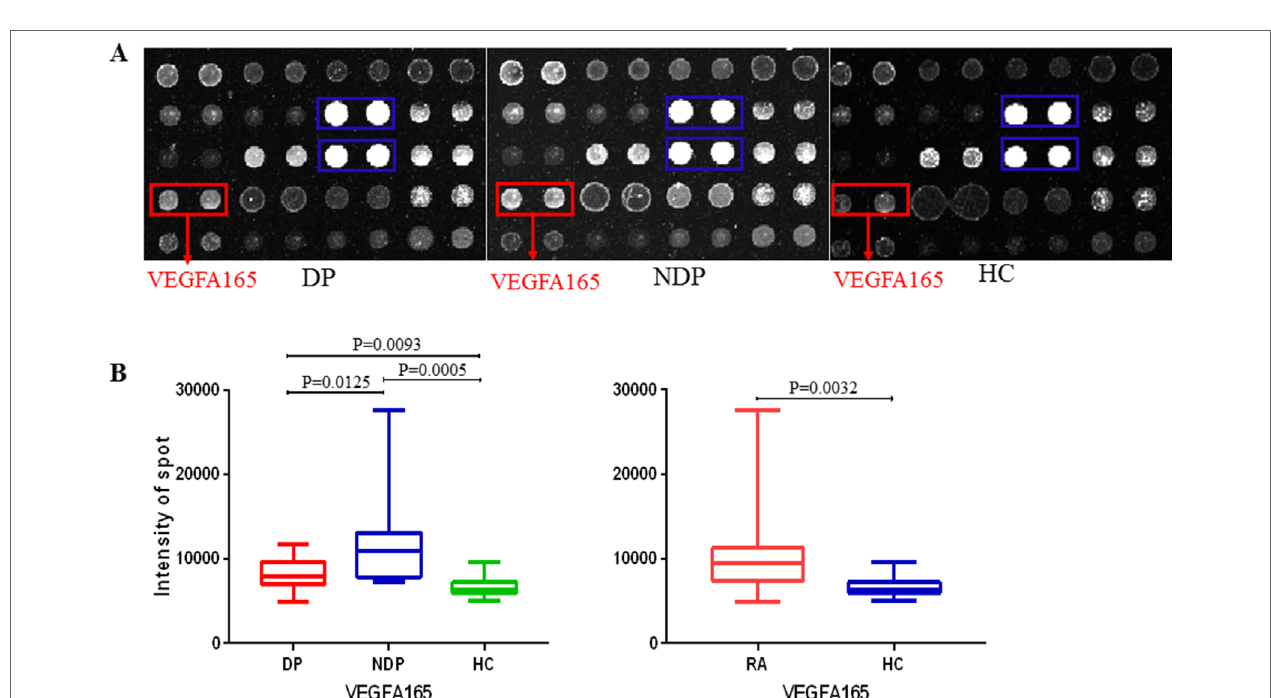
FIGURE 3 | Probing results of the human protein chip with DP and NDP sera. (A) Fifteen DP, 15 NDP, and 15 HC serum samples were diluted 1:20 and individually incubated with the human protein chip, followed by the addition of the anti-human IgG antibody (Cy3-conjugated). Chips were dried and scanned to acquire the images. Representative areas of the images are illustrated. Red boxes indicate the positive candidate autoantigens, and blue boxes indicate human IgG (the positive control). (B) Fifteen DP, NDP, and 15 HC. The signal distributions of VEGFA165 reacting with the serum samples is displayed. The bar within the rectangle indicates the median